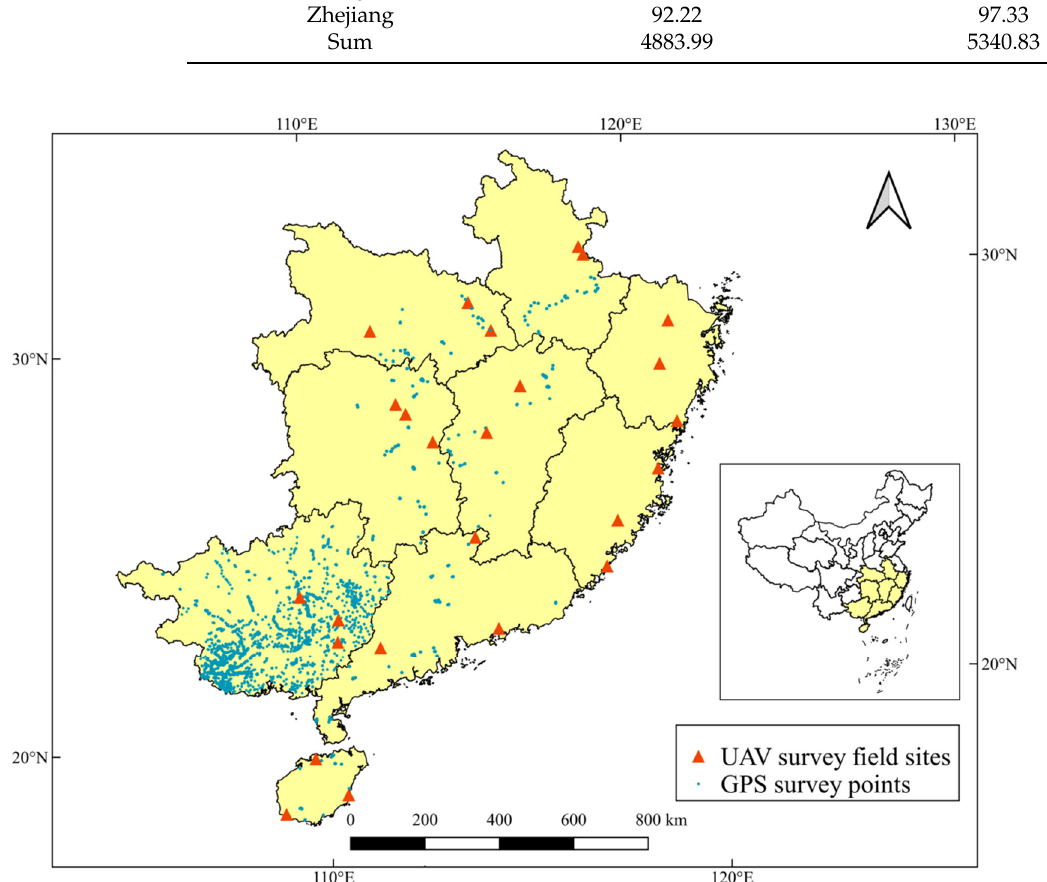
Figure 1. Study area spans nine provinces over China (the yellow region). The solid black lines represent the boundary of the provinces. The red triangles indicate 25 unmanned aerial vehicle (UAV) field survey sites in 2018, and each site covers 1 km 2 field area. The blue dots indicate GPS survey points from 2018 to 2020.